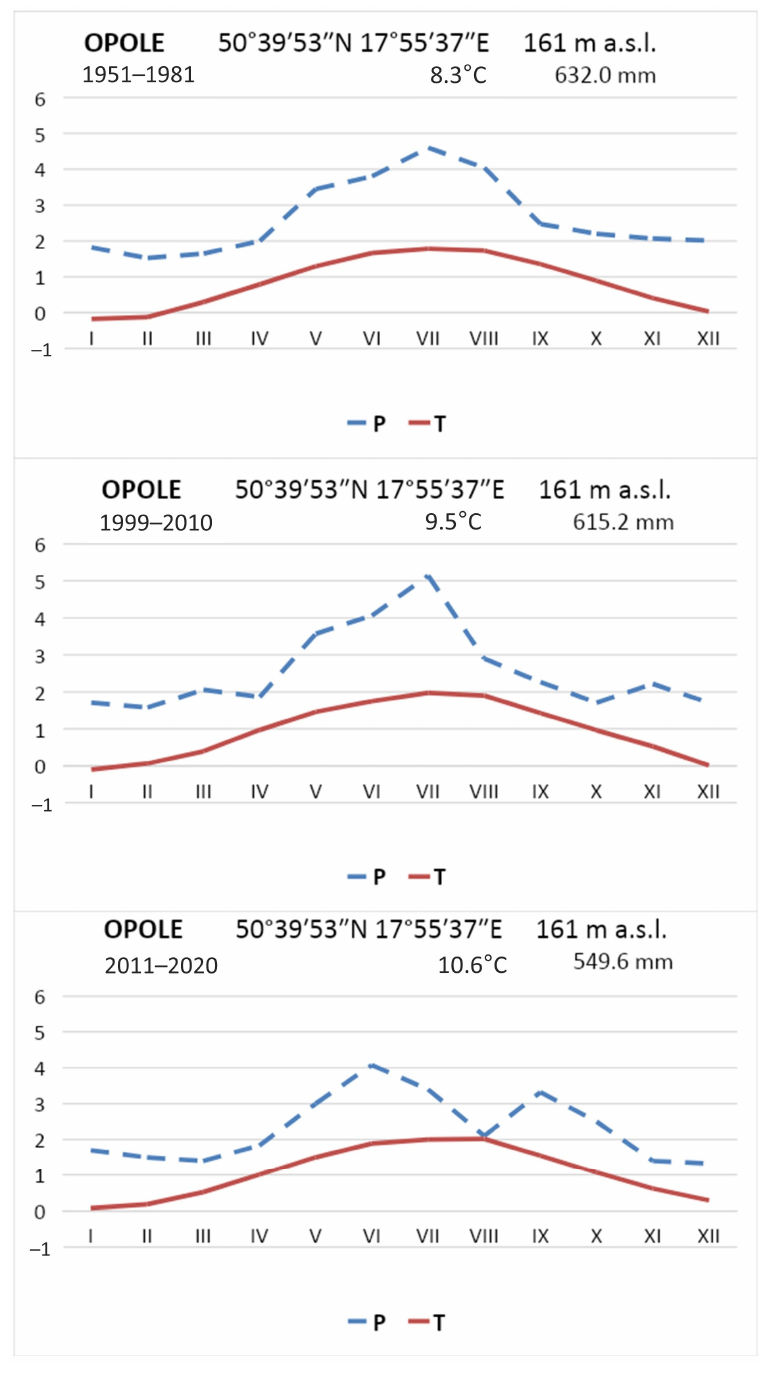
Figure 8. Walter diagrams for Opole station in the periods 1951–1986, 1999–2010 and 2011–2020. One unit on the axis corresponds to 20 mm rainfall (P) and 10°C air temperature (T).